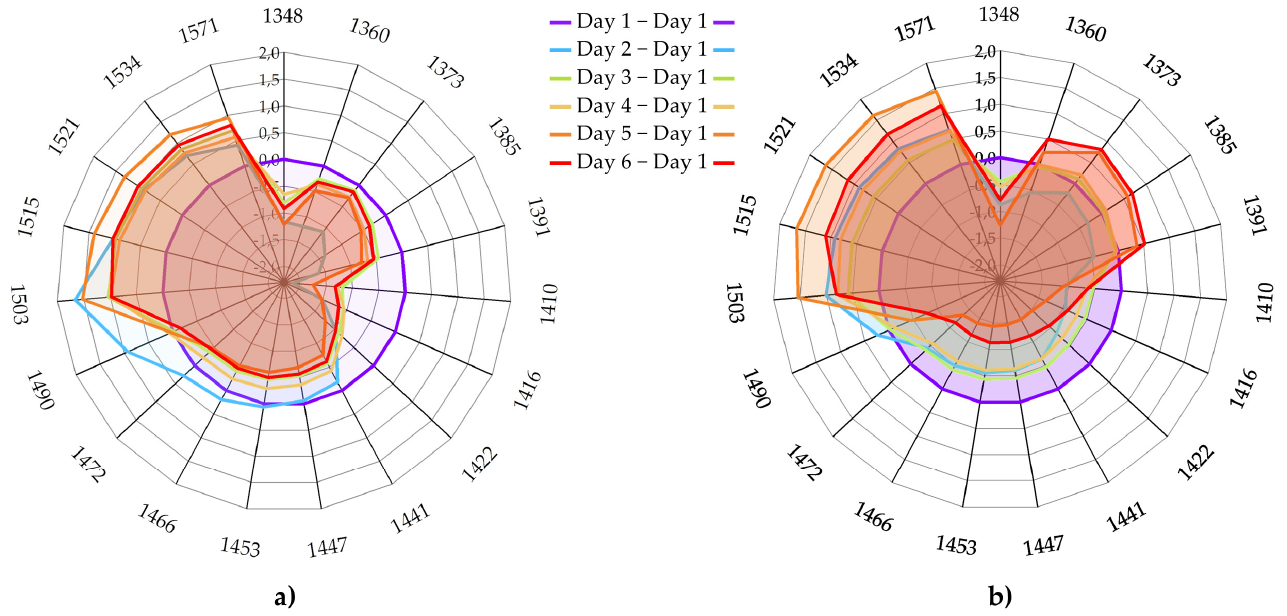
Figure 13. Aquagrams of lettuce leaves calculated for each day of storage for ( a ) inner leaves (N = 6), and ( b ) outer lettuce leaves (N = 6). The aquagrams are calculated using pre-treated spectra (sgol-2-17-0 + SNV + averaging for all spectral replicates and consecutive replicates) and subtraction of the aquagram of the leaves for the first day of storage.